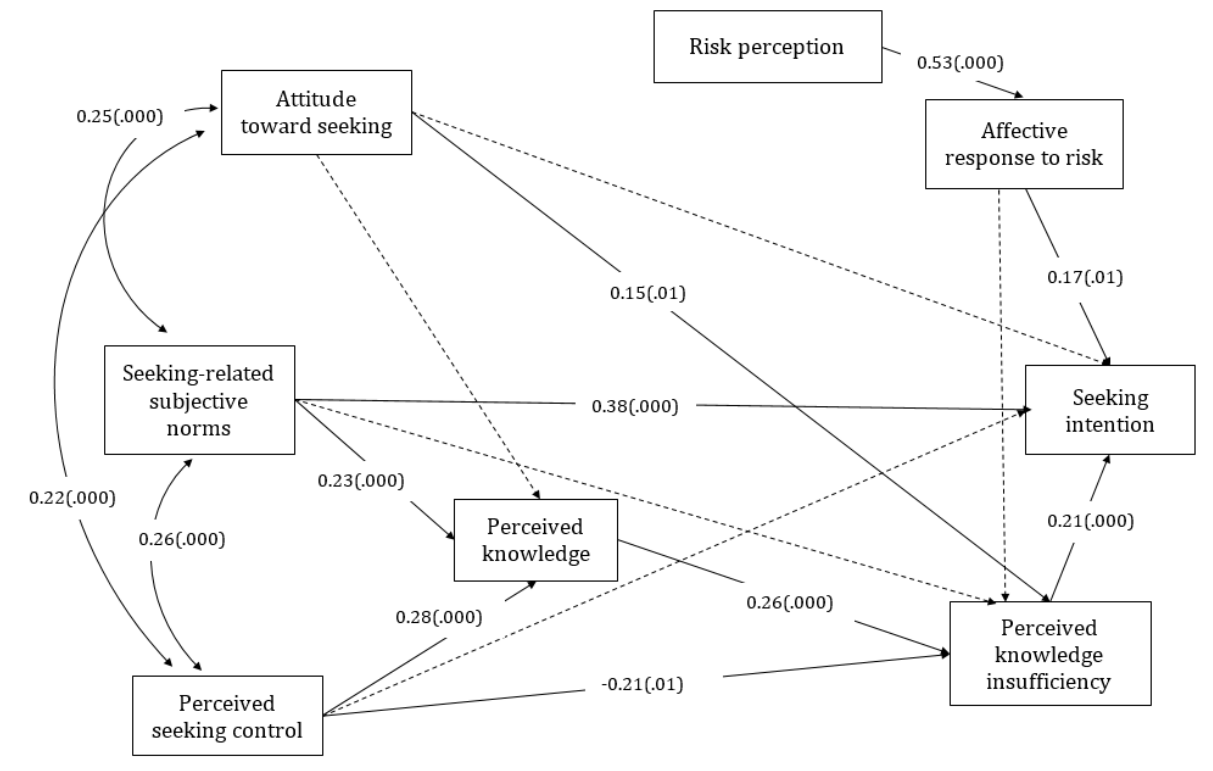
Figure 2. The planned risk information seeking model of the US sample. Dashed lines denote hypothesized nonsignificant paths. The model includes effects of control variables, which are not displayed. (.000) represents significant path coefficients at the .001 level and (.01), at the .05